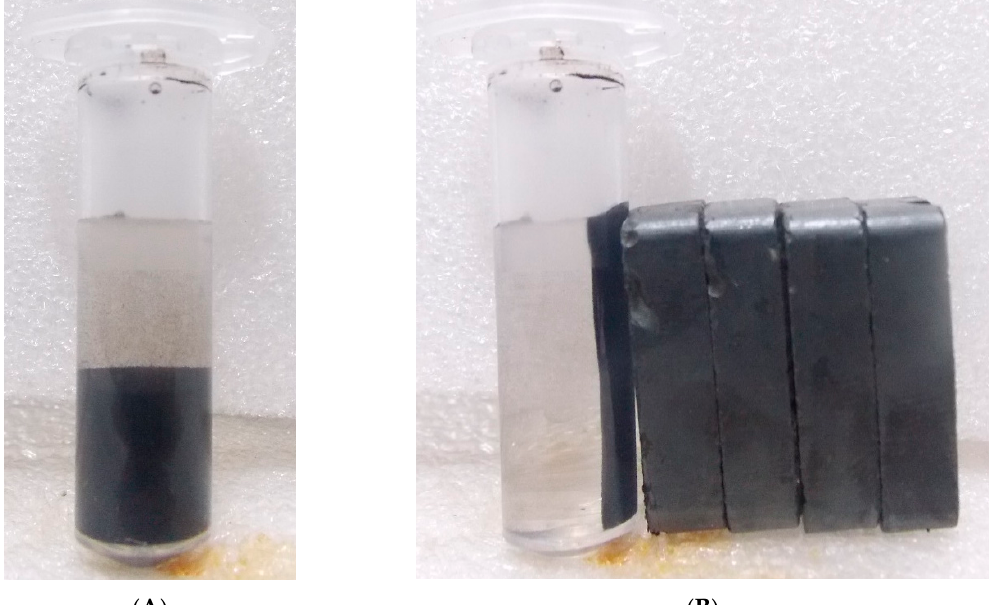
Figure 1. Iron oxide nanoparticles ( A ), Iron oxide nanoparticles (IONPs) responding to magnet ( B ).